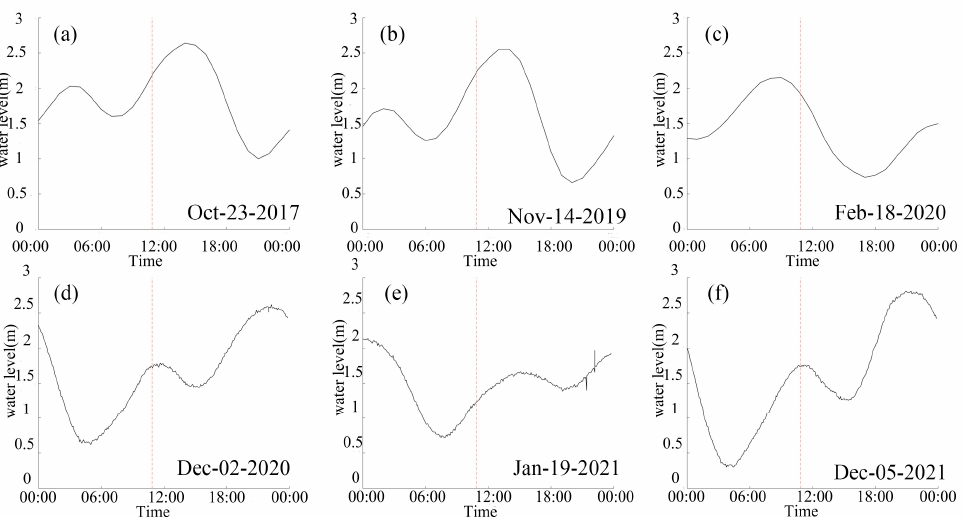
Figure 7. Sea level measured at the Shek Pik tidal gauge station. The tidal data for 23 October 2017 ( a ), 14 November 2019 ( b ), 18 February 2020 ( c ), 2 December 2020 ( d ), 19 January 2021 ( e ), and 5 December 2021 ( f ) in the PRE.